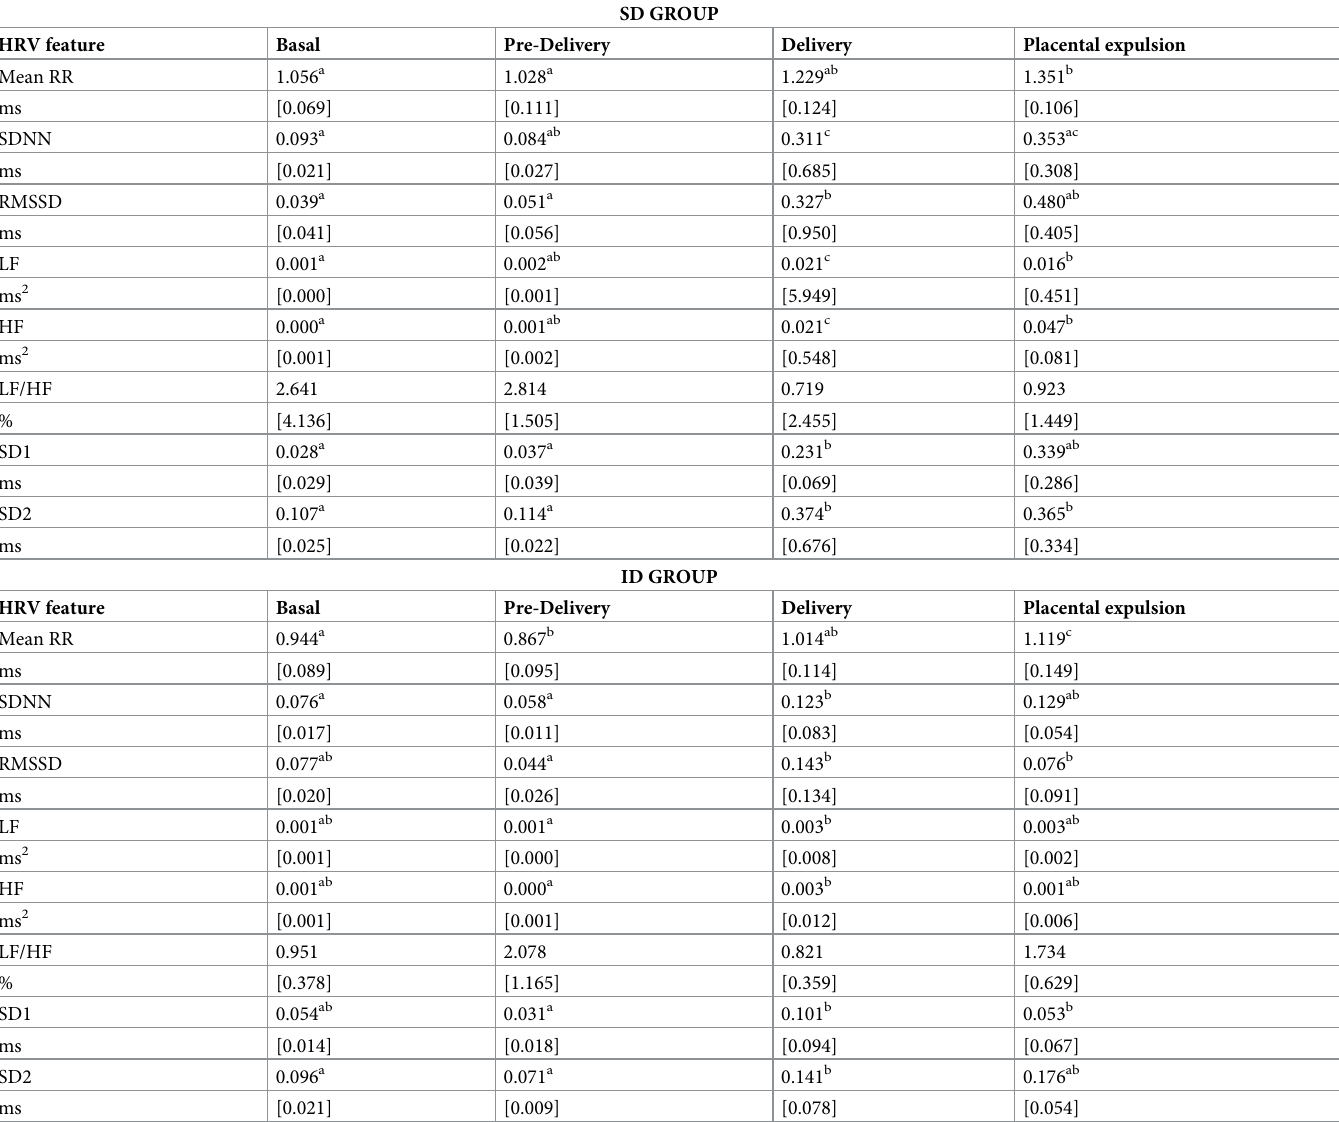
Table 2. HRV features obtained for each analyzed period and for both groups. Data are expressed as median and absolute deviation from the median. Within the same row, different superscripts mean statistical differences over time (intraGA): a 6¼ b 6¼ c 6¼ d (all p < 0.008). The absence of superscripts within the same row means no statis- tical differences over